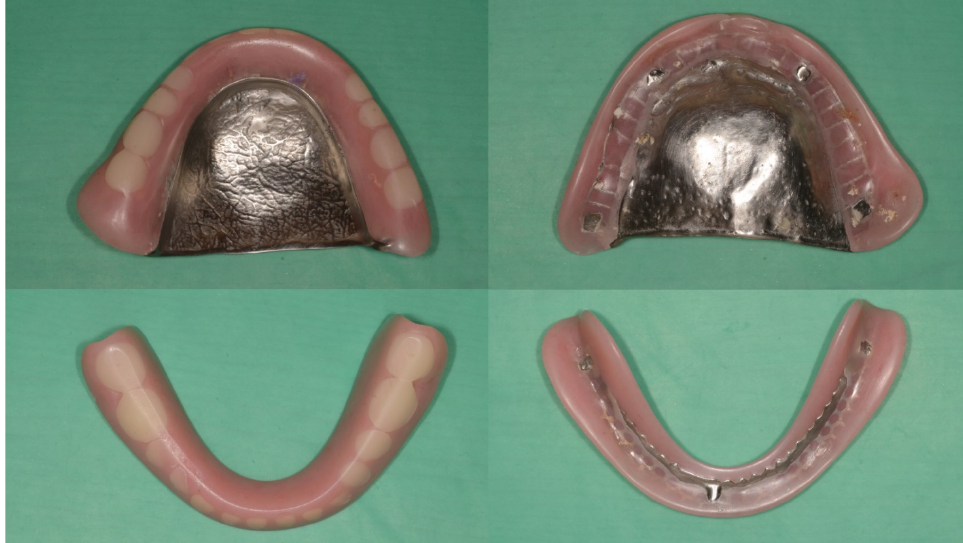
Figure 4. Another case in which the clinical remount procedure is contraindicated on existing dentures. The vertical dimension of the dentures is extreme low, and the artificial teeth are heavily worn.